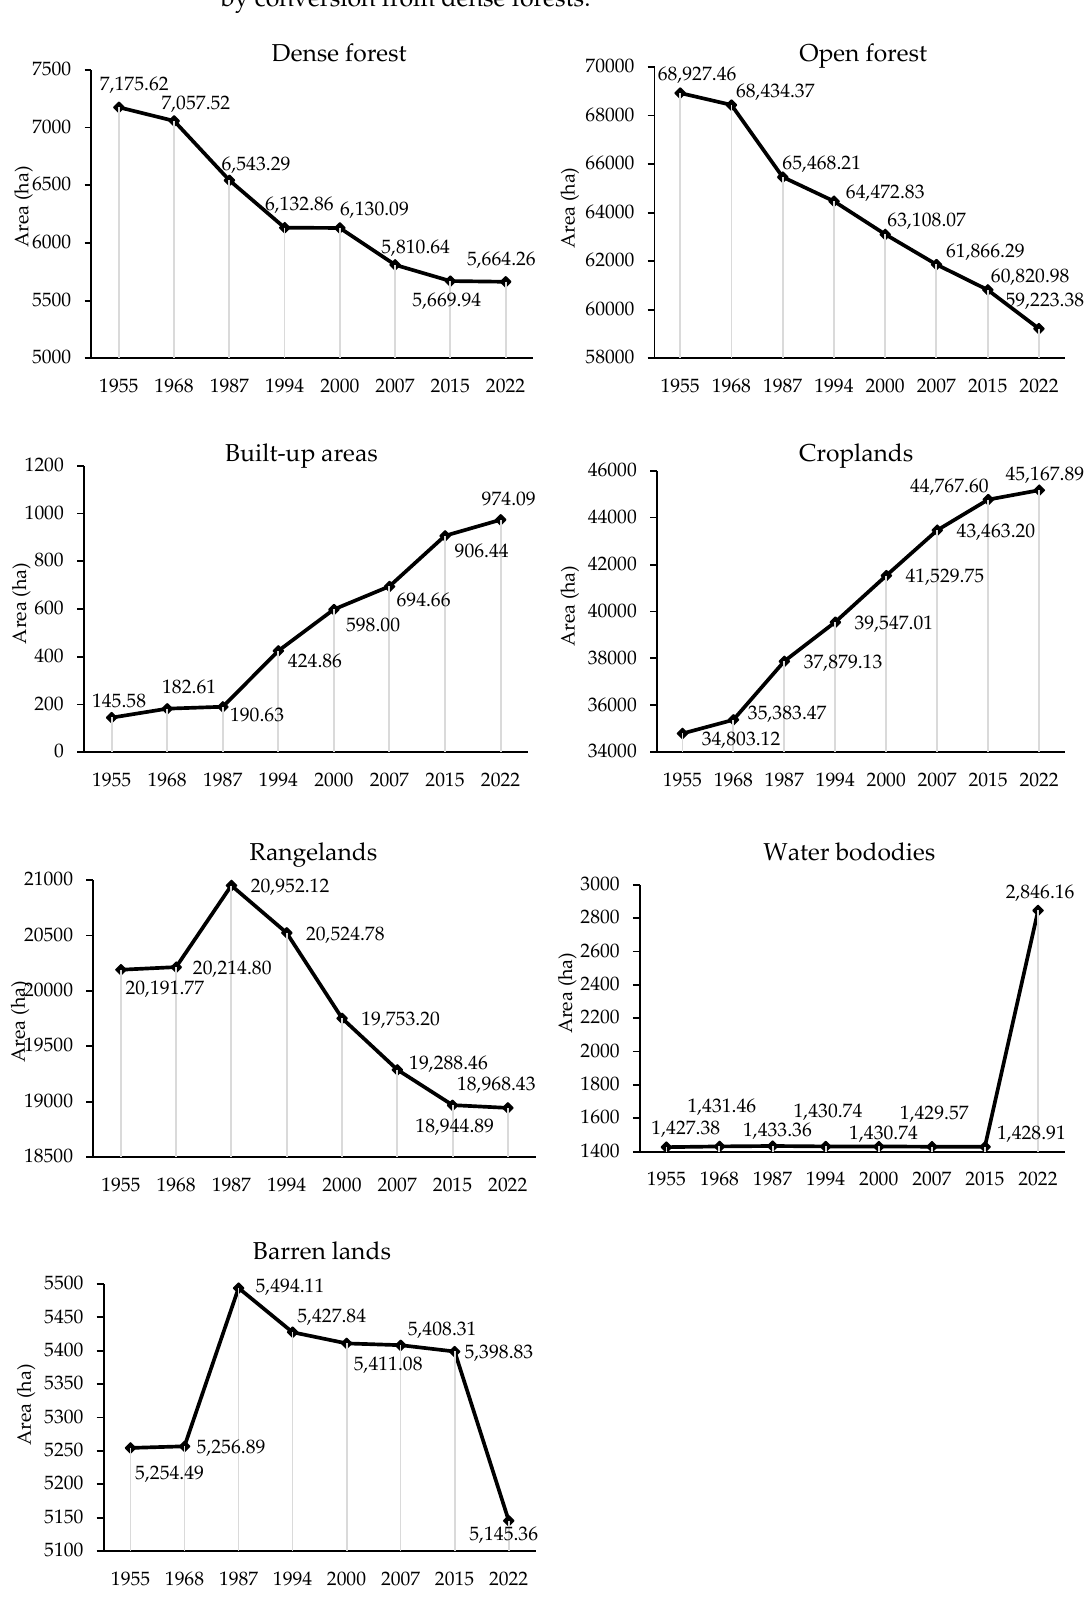
Figure 5. Sardasht County’s land use maps within the studied time periods.